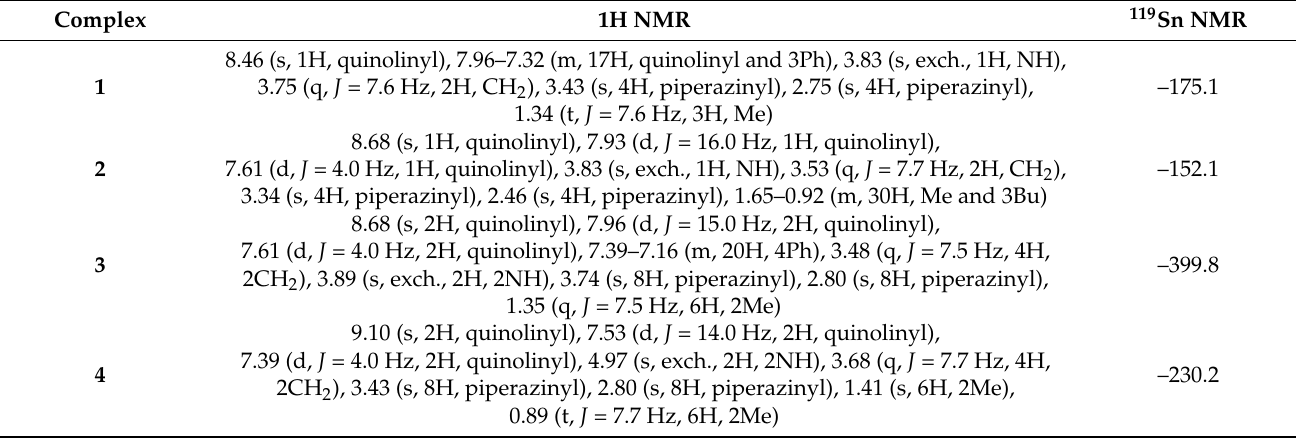
Table 3. 1 H and 119 Sn NMR spectral data for 1–4